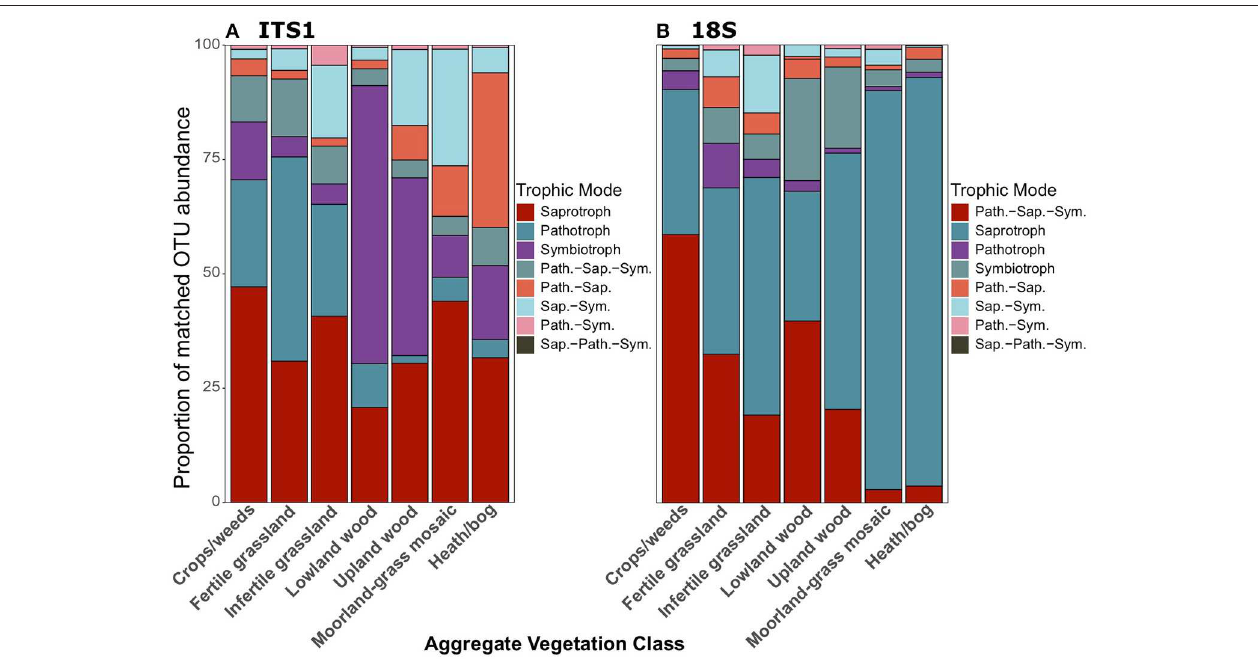
FIGURE 7 | Proportionate abundances of fungal OTUs matched to FUNGuild trophic groups for (A) ITS1 and ( B) 18S data across Aggregate Vegetation Classes. Aggregate Vegetation Classes are ordered from most (Crops/weeds) to least (Heath/bog) productive. Abbreviations for multi-trophic mode groups are as follows: Path.-Sap. (Pathotroph-Saprotroph); Path.-Sap.-Sym. (Pathotroph-Saprotroph-Symbiotroph); Path.-Sym. (Pathotroph-Symbiotroph); Sap.-Path.-Sym (Saprotroph-Pathotroph-Symbiotroph); Sap.-Sym.